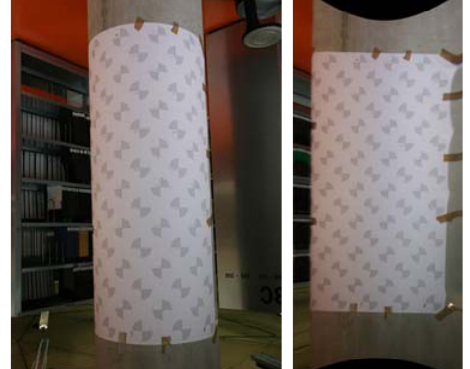
Figure 11. Model of cylindrical element and unwrapping